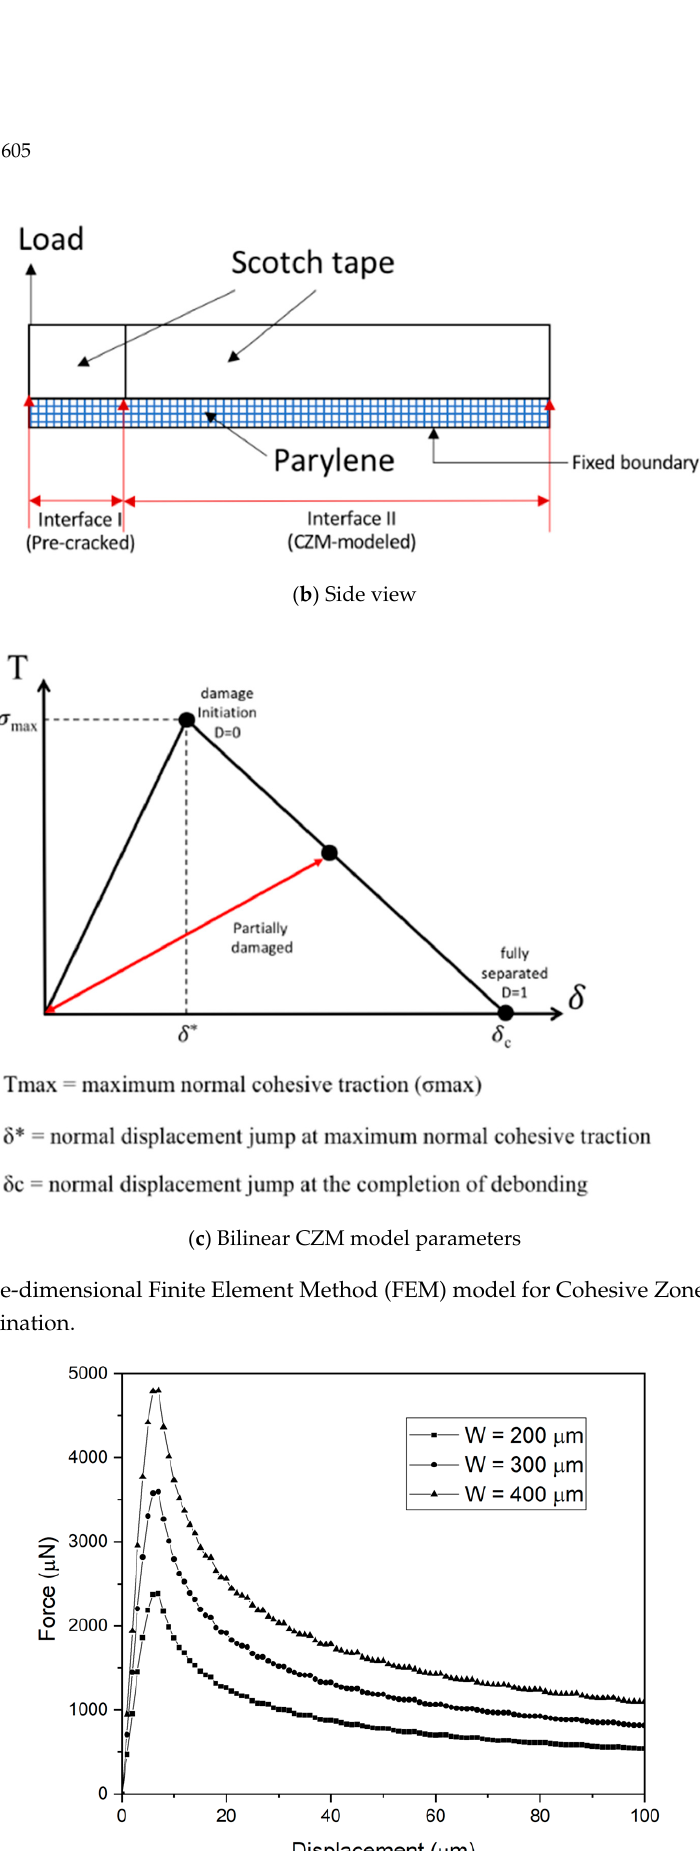
Figure 11. Force-displacement curves as function of metal width.